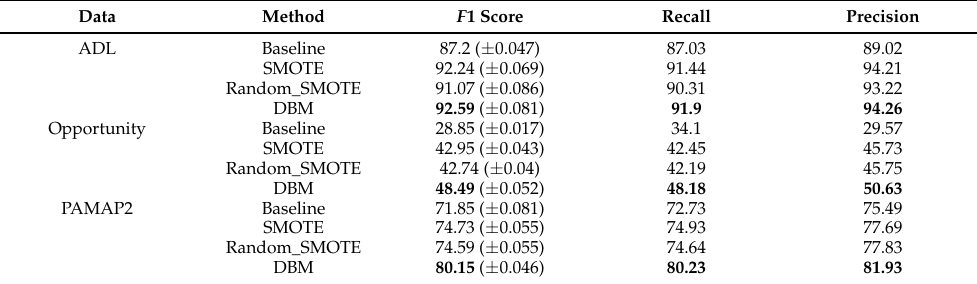
Table 4. Distance-based method results. Comparing the performance of MLP on DBM, SMOTE, and Random_SMOTE for multiple datasets. The reported mean of F 1 score and ( ± standard deviation), recall, and precision are obtained from 30 repetitions. The F 1 score, recall, and precision are in %. Highest scores are shown in bold.